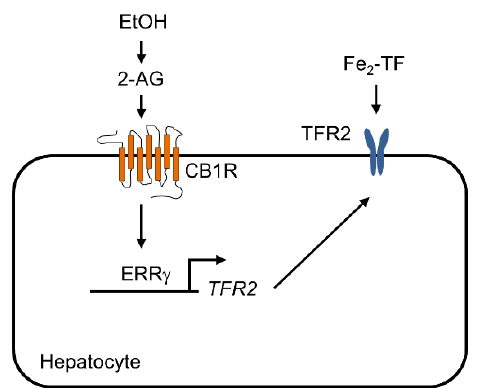
Figure 6. Proposed role of ERR γ in CB1 receptor-mediated TFR2 gene expression in hepatocytes. An endocannabinoid 2-AG increases ERR γ expression by activating CB1 receptor signaling in hepatocytes, subsequently resulting in induction of TFR2 gene expression which contributes to hepatic iron accumulation.